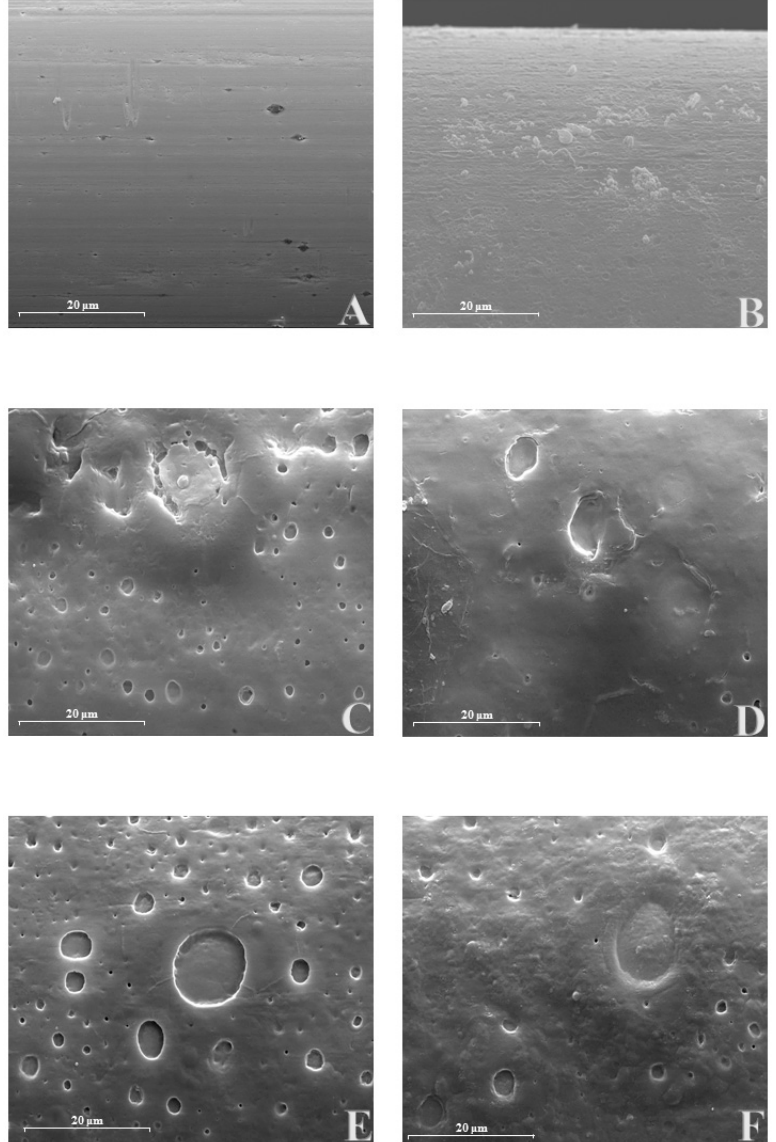
Scanning electron microscopy (SEM) of di ff erent biosensor designs at 2000x magnification. Panel A : Pt c ; Panel B : Pt c / PPD; Panel C : Pt c / PPD / PEI(1%) 2 / GlutOx 5 / DEG(0.1%); Panel D : Pt c / PPD / PEI(1%) 2 / GlutOx 5 / NPG(0.1%); Panel E : Pt c / PPD / PEI(1%) 2 / GlutOx 5 / TEG(0.1%); Panel F : Pt c / PPD / PEI(1%) 2 / GlutOx 5 / GLY(0.1%).